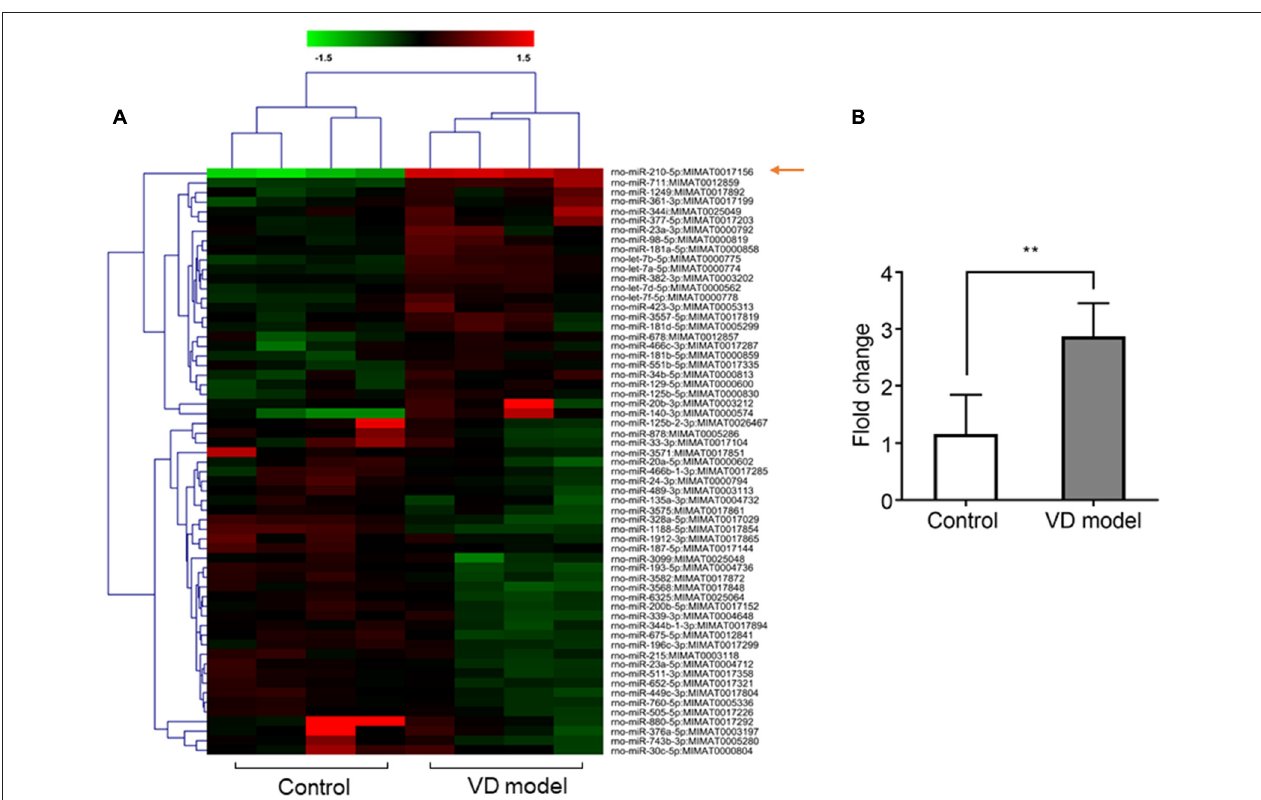
FIGURE 2 | The expression of microRNA (miRNA)-210-5p is significantly increased in hippocampal tissues of vascular dementia (VD) model rats when compared with control rats. (A) miRNA profile was measured through microarrary ( n = 4/group). In cluster diagram, red color represents relatively high quantity of the miRNAs expression, and the green means relatively low. (B) mir210 expression was tested by quantitative PCR (qPCR; n = 6/group). Data are shown as mean ± SD values, and statistical significance between both groups is defined as ∗∗ p <